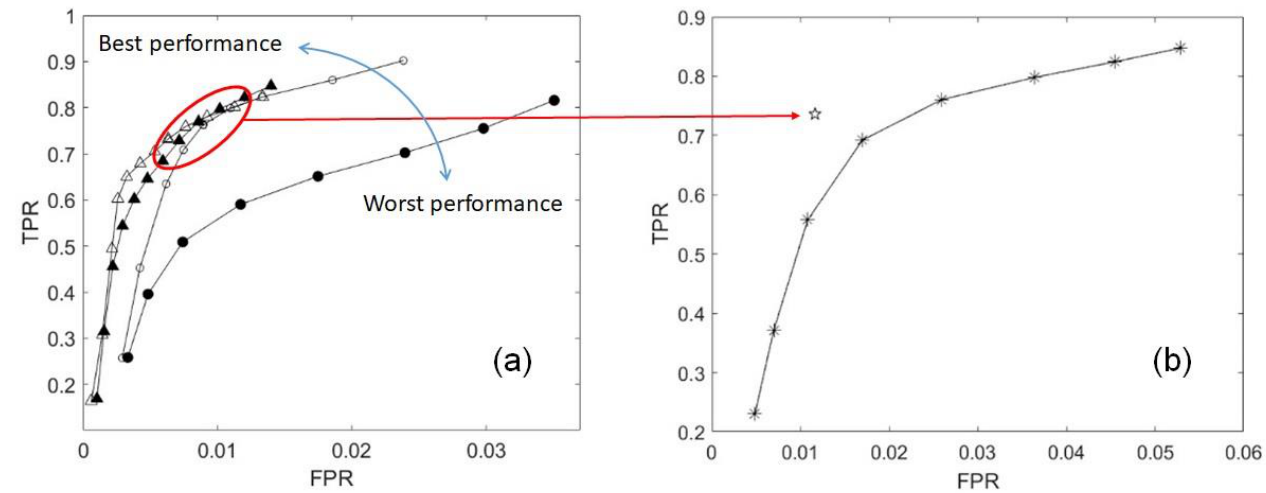
Figure 9. True Positive Rates vs. False Positive Rates. ( a ) ROC curves for classifiers trained on Set 2 (black circles); Set 4 (empty circles); Set 3 (black triangles); Set 5 (empty triangles). The curves for Sets 3 and 5 (empty markers) are both closer to the upper-left corner than those for Sets 2 and 4 (black markers), respectively, denoting better performance. ( b ) ROC curve for Set 1 (all plastics together), compared with the optimal two-stage classifier (Set 4 OR Set 5 results for optimal parameters—isolated star), which is closer to the upper-left corner of the figure than any point of the all-plastics ROC curve.